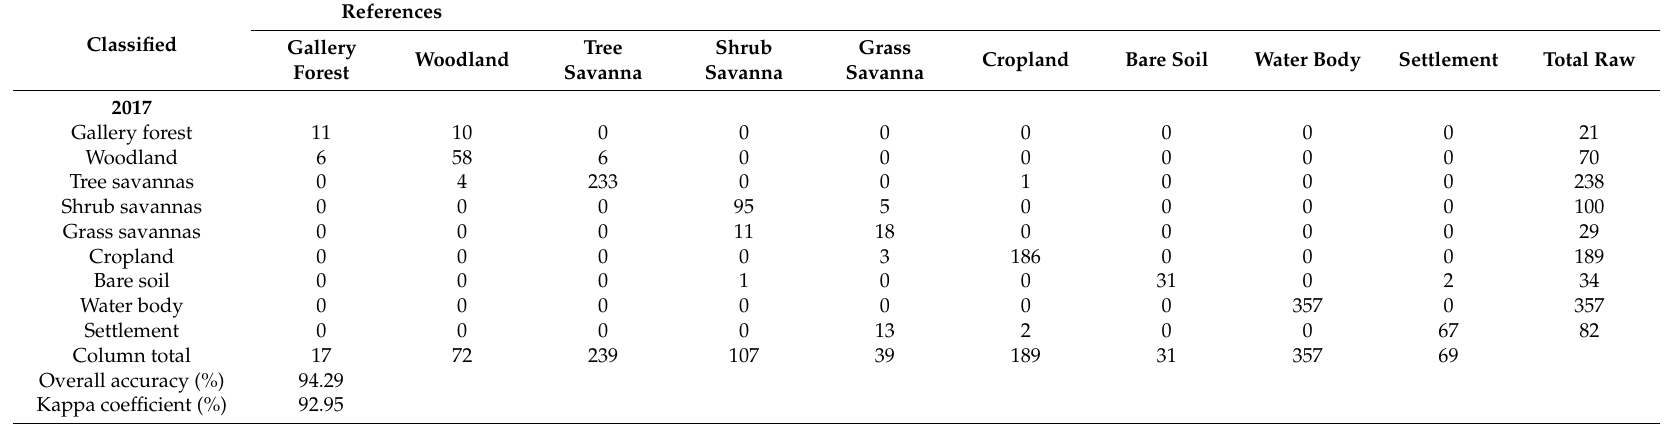
Figure 2. Main land use and land cover category ( a ) and their proportion ( b ). Table 3. Confusion matrix and classification accuracy for 2017 sentinel-2 image.